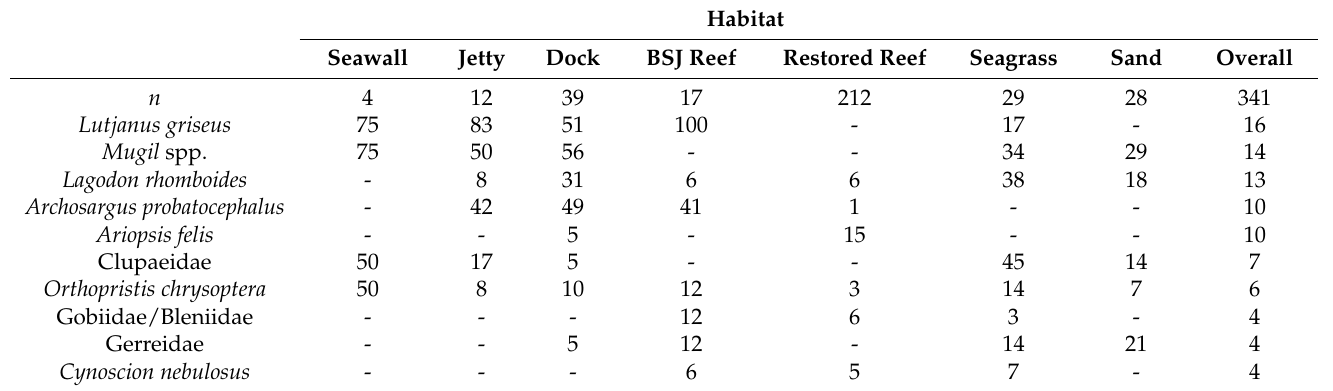
Table 1. Frequency of Occurrences (%) of taxa present in ≥ 5% of non-empty underwater videos by habitat. n represents the total number of video replicates by habitat. Values are occurrences across all analyzed videos, including empty ones, hence some “Overall” values are below 5%. “Restored Reef” habitats were in East Bay, all others were in Perdido